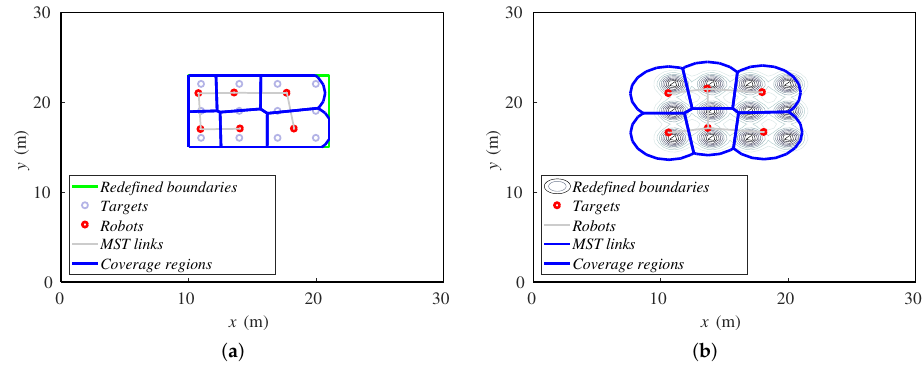
Figure 13. Final positions of agents and targets for ( a ) redefining boundaries and ( b ) importance functions methods.